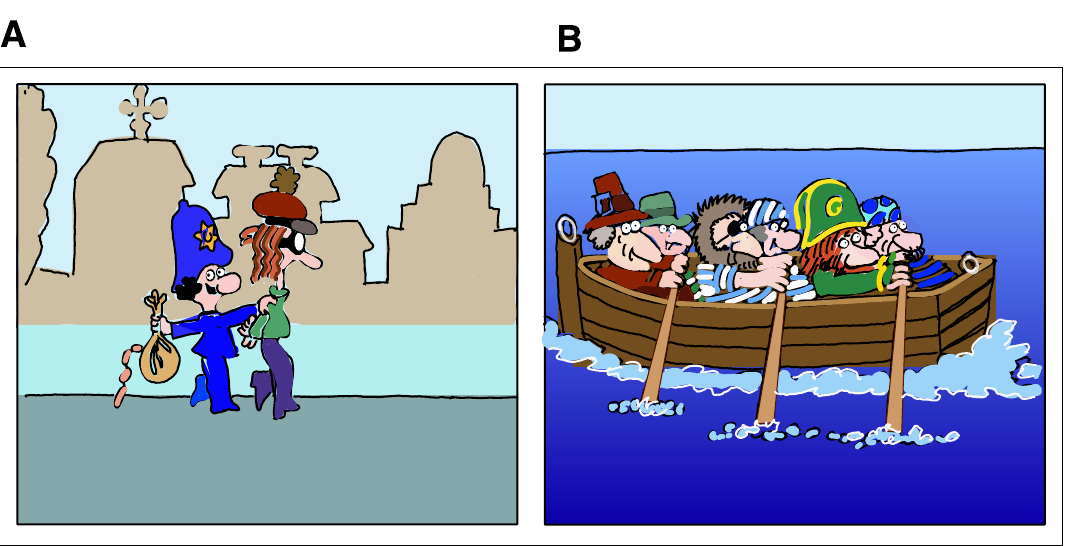
Figure 1. Screenshots from the cartoon videos: Image "( A )" on the left illustrates the action-packed video excerpt from an animated cartoon, accompanied by a rhythmically and melodically rich tune, while image "( B )" on the right illustrates another excerpt from the same animated cartoon but a rather monotonous and eventless sequence, with repetitive, and predictable actions, accompanied with a unison background music. The illustrations were redrawn from the original